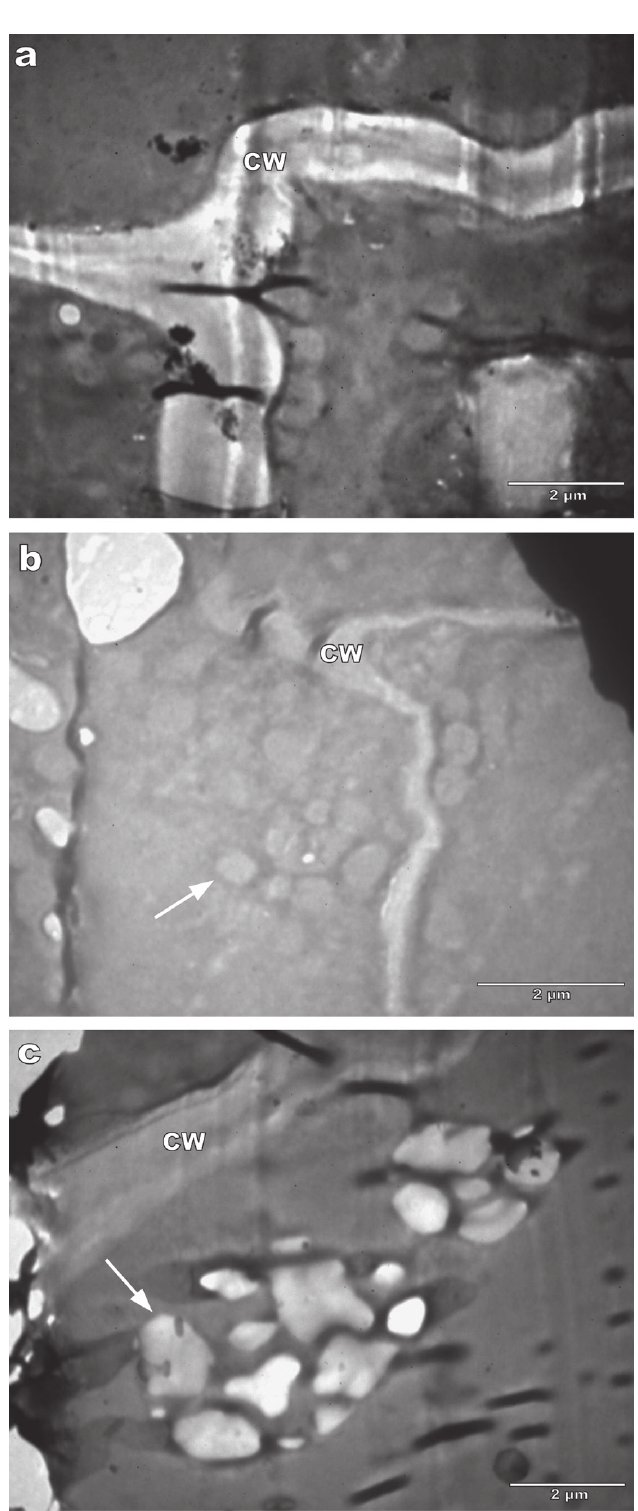
Figura 9 - Transmission electron micrographs of the callus Type 4. A) Thin cell wall. B) Numerous mitochondria (arrows) and C) amyloplasts (arrows). Cell Wall